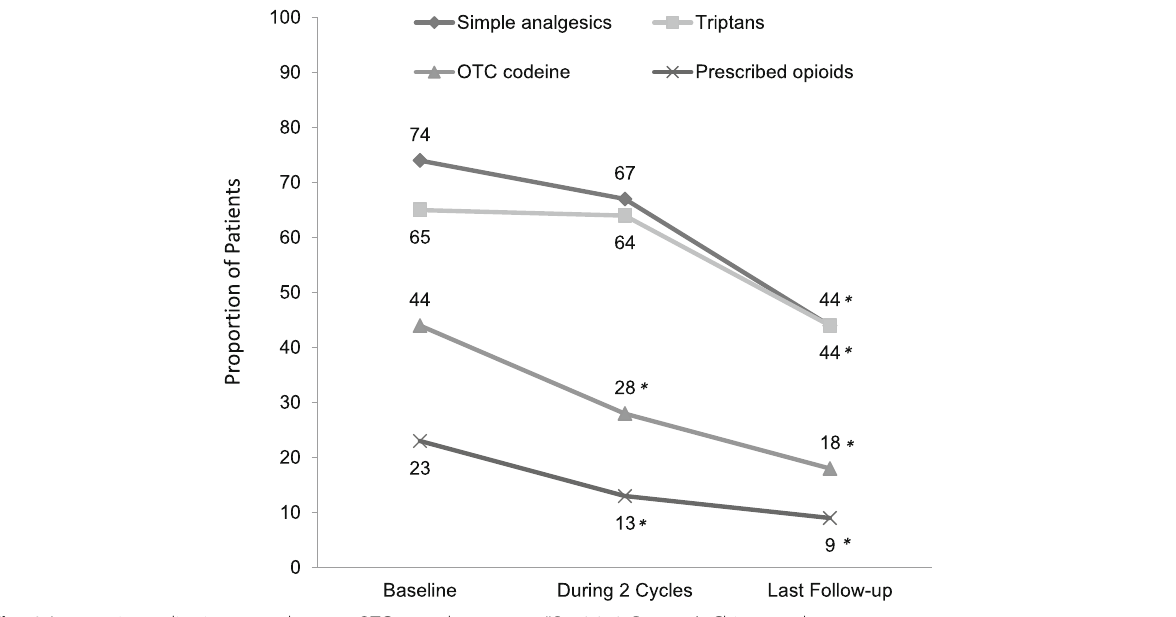
Fig. 6 Acute pain medication usage by type. OTC, over the counter. * P < 0.050, Pearson ’ s Chi-squared